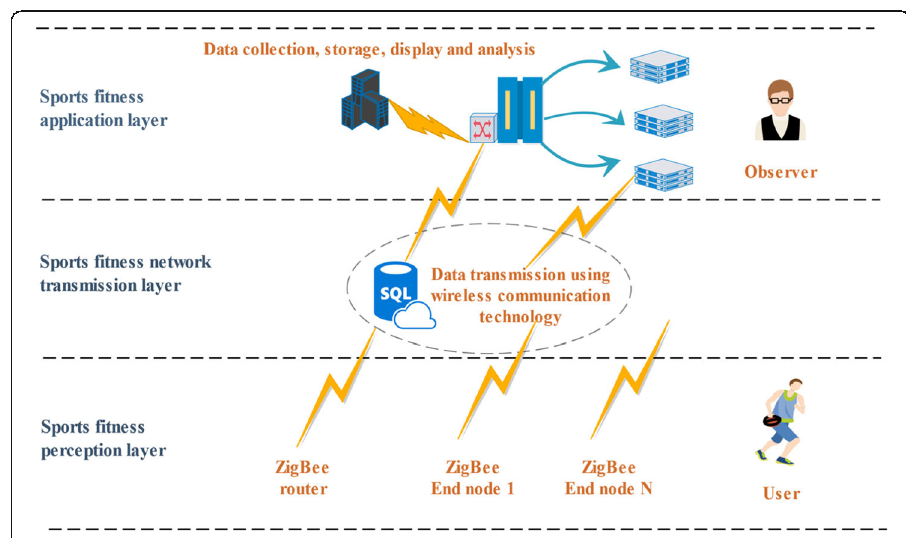
Fig. 2 Schematic diagram of the framework of sports fitness management technology